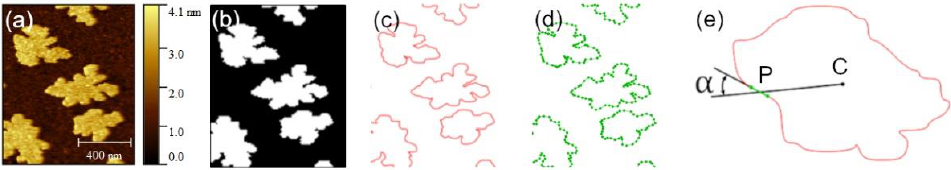
Figure 2. Graphical steps to obtain polygonal chains describing island contours. ( a ) Original AFM image; ( b ) two-levels bitmap image of well-identified islands are clearly; ( c ) Contours of the islands traced as a series of lines and Bezier curves; ( d ) Polygonal chains describing island contours (dots are vertexes of linear segments). For graphical purposes, linear segments of polygonal chains are 20 times lower than those used for calculating S . ( e ) Angle α between a segment centre of the island contour (green line with centre P) and the radial line to the centroid C of the island.